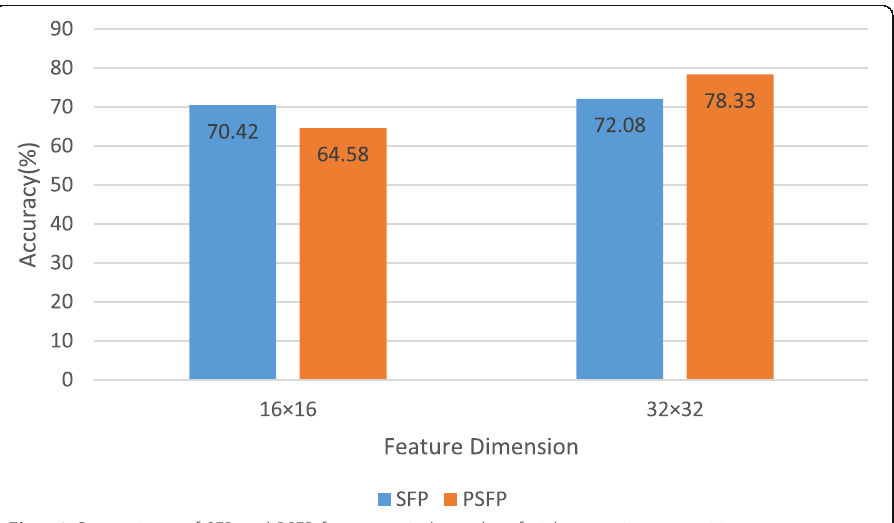
Fig. 10 Comparisons of SFP and PSFP for person-independent facial expression